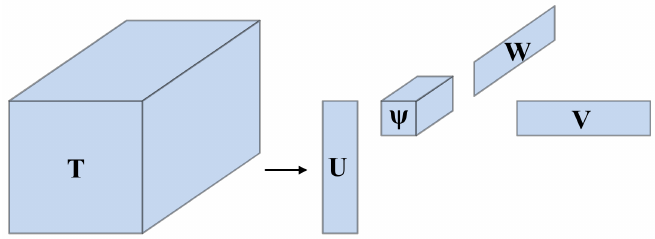
Figure 3. Illustration of HOSVD